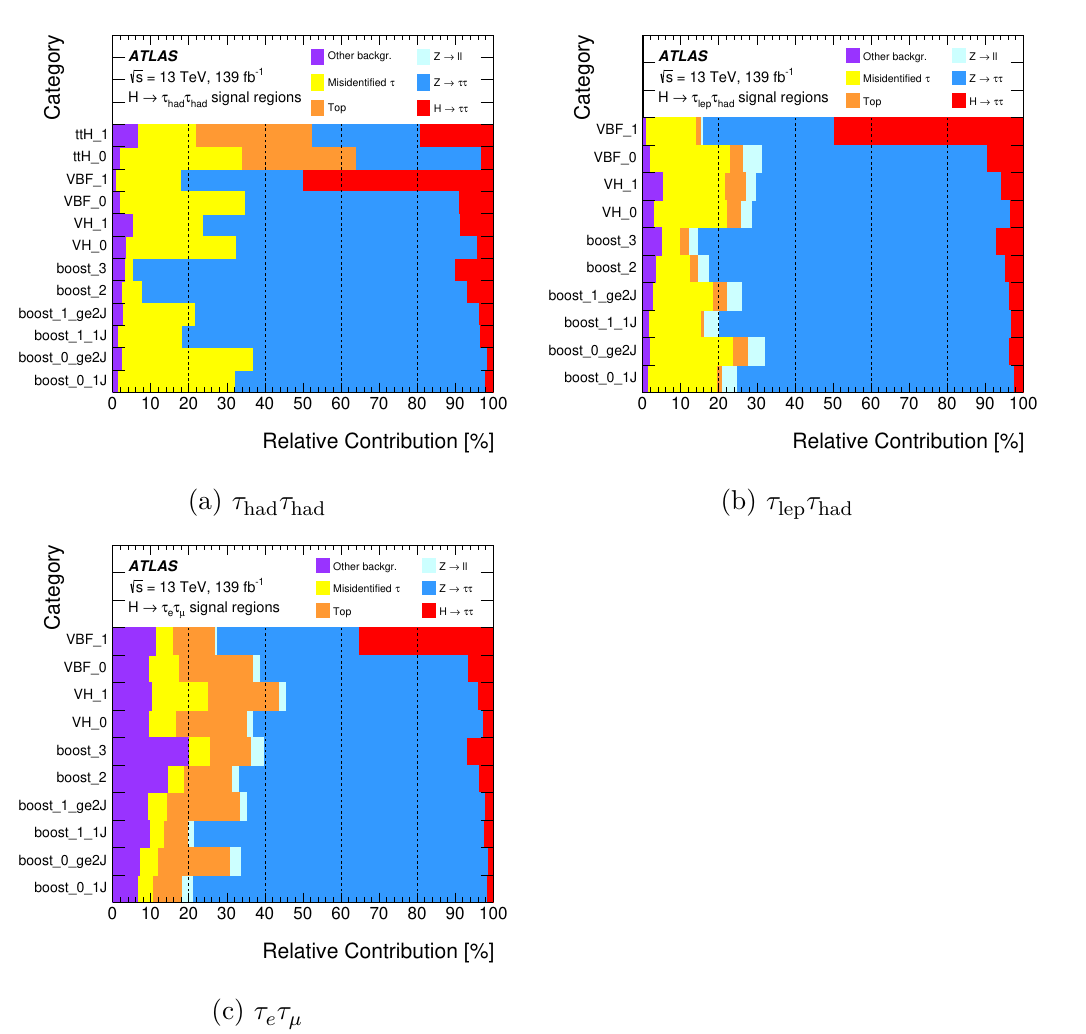
Figure 3. Relative contribution of each process to the total measured yields in each category of the analysis for the (a) τ ‘Other backgr.’ includes diboson and H → WW ∗